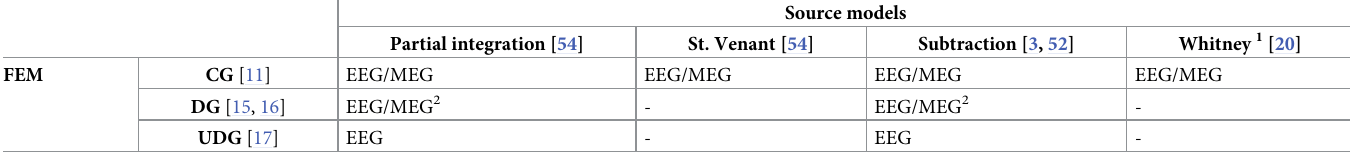
Table 1. Overview of source models currently supported for EEG/MEG by DUNEuro for different FEM discretization